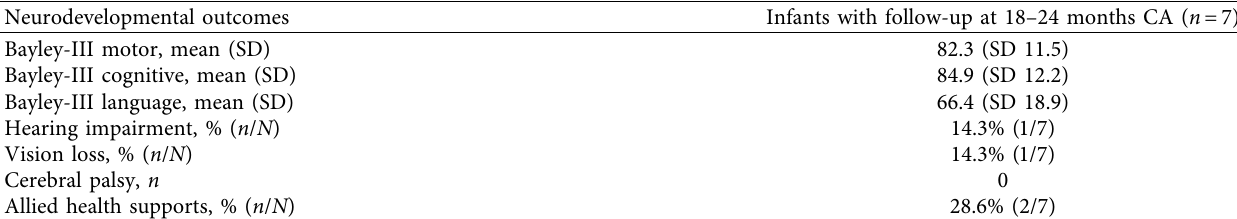
Table 2: Neurodevelopmental outcomes at 18–24 months CA amongst survivors of pPPROM. Neurodevelopmental